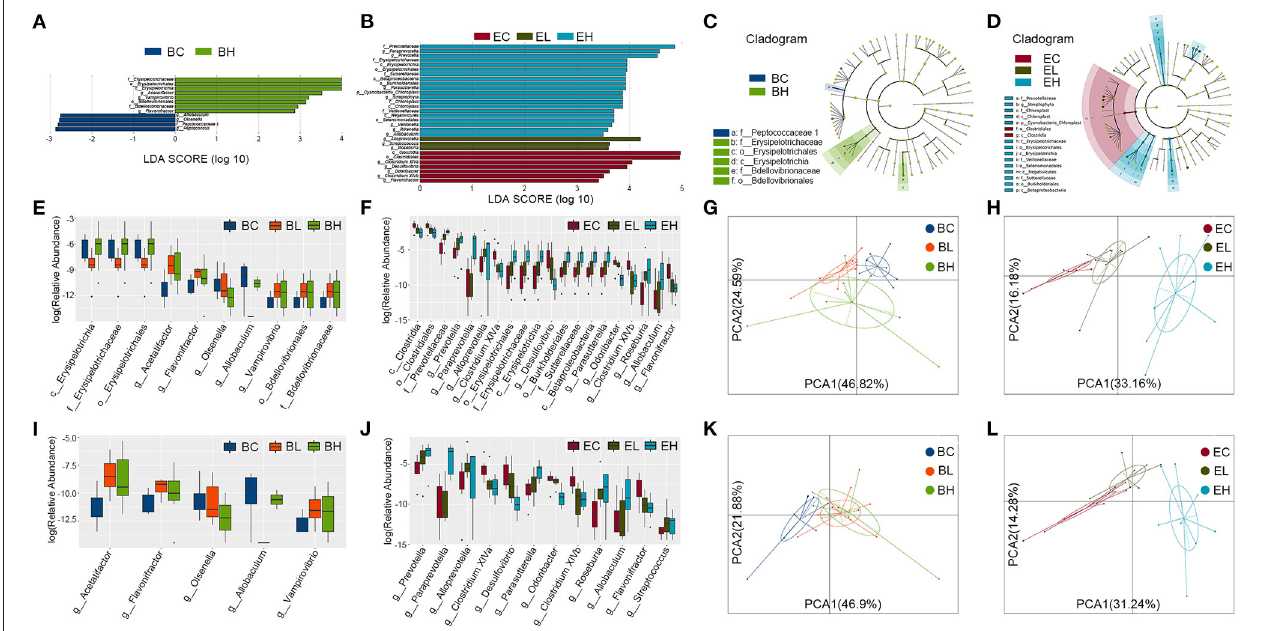
FIGURE 5 | Differential species and metabolic pathways before and after leucine supplementation. (A,B) Linear discriminant analysis (LDA) effect size (LEfSe) analysis revealed 12 and 30 discriminative features at all the taxon levels in the baseline and endpoint groups (LDA > 2); (C,D) taxonomic cladograms in the baseline and endpoint groups; (E,F) Kruskal–Wallis rank sum test showed 10 and 30 (top 20) significantly different species at all the taxon levels in the baseline and endpoint groups; (G,H) the PCA plots at all taxon levels in the baseline and endpoint groups; (I,J) Kruskal–Wallis rank sum test revealed 5 and 15 (top 12) significantly different species at genus level in the baseline and endpoint groups; (K,L) the PCA plots at genus level in the baseline and endpoint